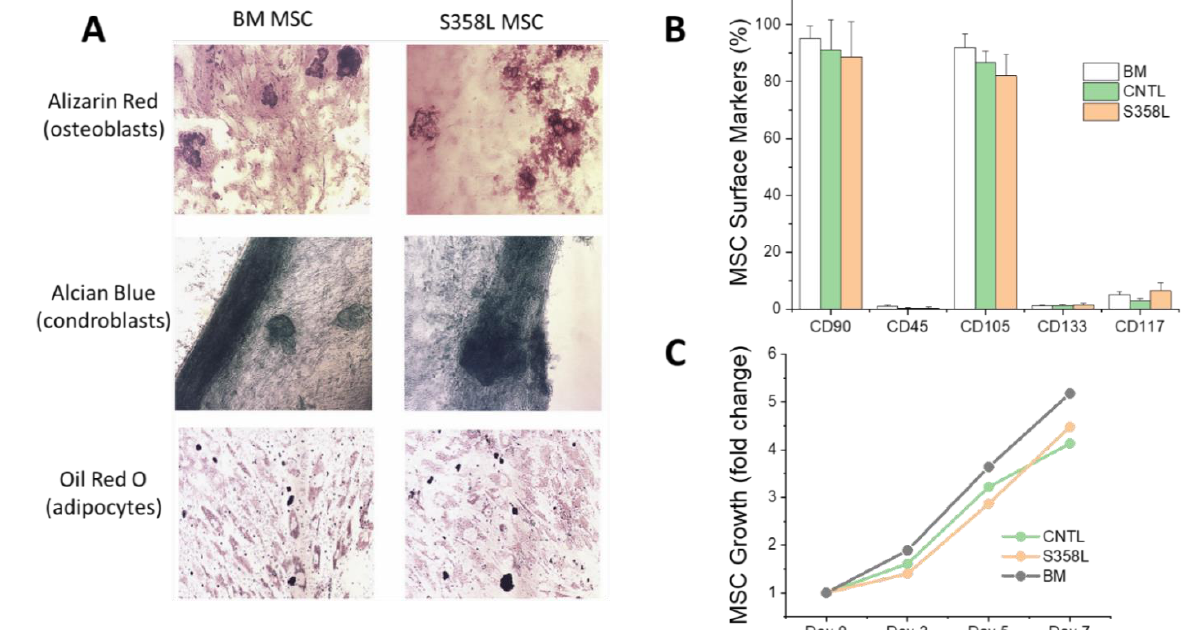
Figure 3. ( A ) shows the multi-lineage potential of bone marrow (BM) MSCs (as a positive control) and MSCs derived from S358L iPSCs. Both BM and S358L MSCs are shown to have a similar potential for differentiation into to bone (stained with Alizarin Red), cartilage (stained with Alcian Blue) and fat (stained with Oil Red O). ( B , C ) show that BM MSCs and MSCs derived from S358L iPSCs and control (CNTL) iPSCs have a similar cell surface marker expression and growth rate, respectively ( n = 3 for all).